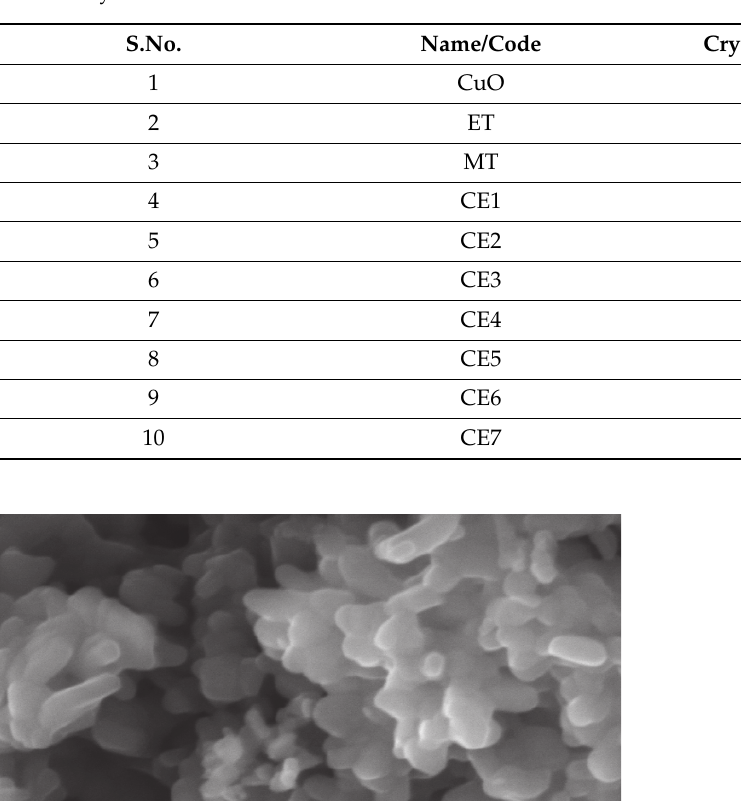
Table 1. Crystallite size of the nanoformulations.